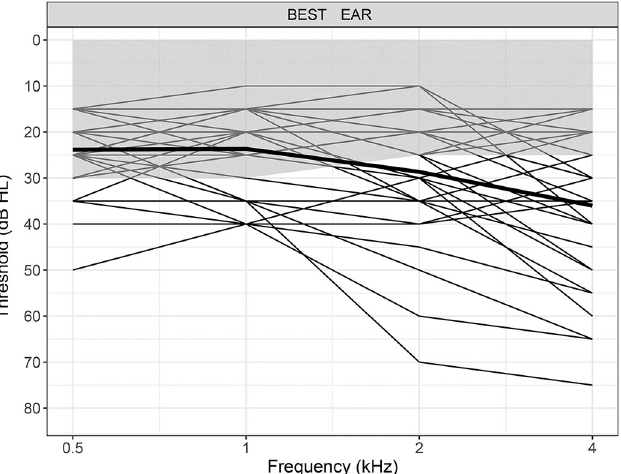
Fig 4. Mean hearing level (dB) dark curve and individual data for older adults across 0.5, 1, 2, and 4 kilohertz. The grey filled area shows the range of the younger adult data.